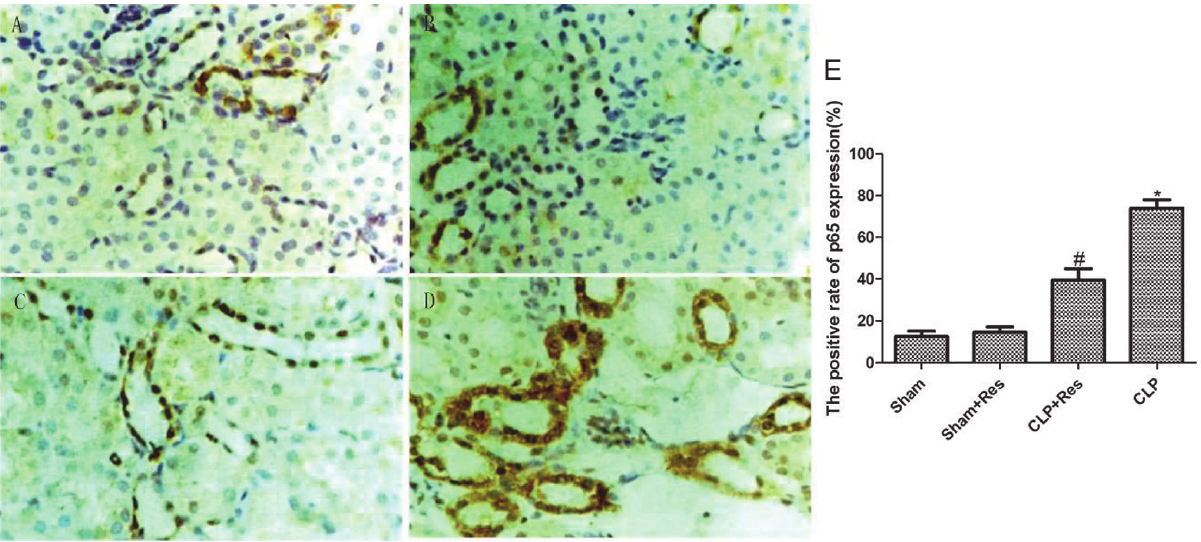
Fig. 5. Expressions and locations of p65 in kidney tissues of septic rats (×400). A: Sham group; B: Sham + Res group; C: CLP + Res group; D: CLP group; E: positive expression rates. *Compared with Sham group, P <0.05; #compared with CLP group, P